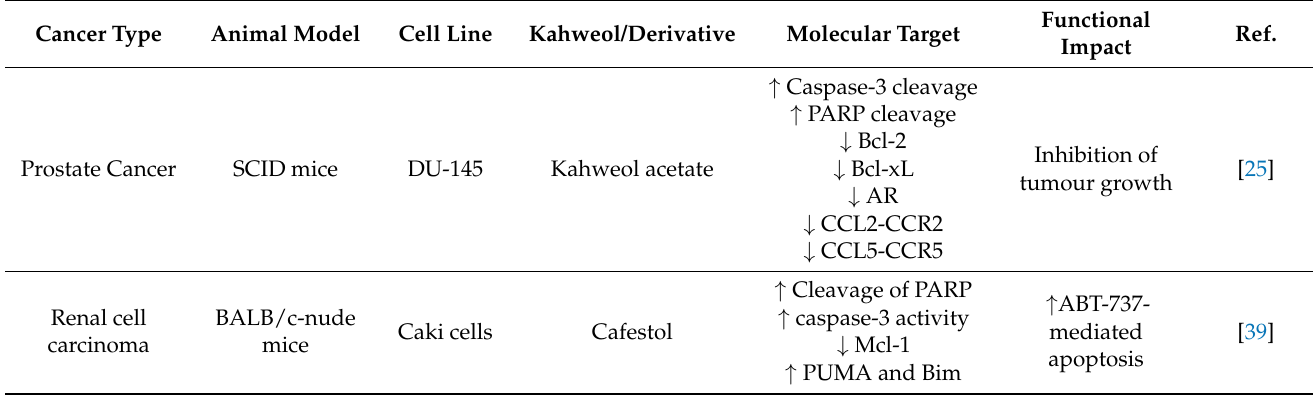
Table 2. In Vivo Impact of Kahweol and Cafestol on Cancer models ( ↑ indicates induction, ↓ indicates